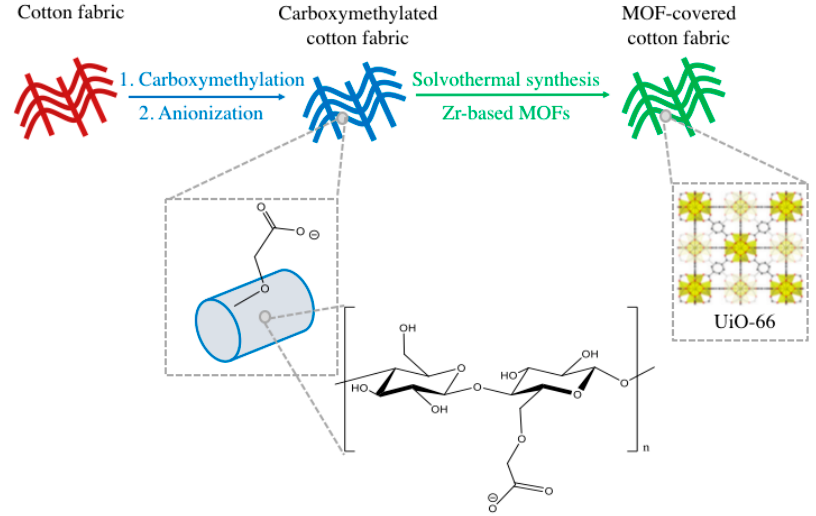
Figure 1. Schematic of the two-step synthesis pathway to grow UiO-66 on the surface of cotton fibers: The first step is the carboxymethylation of cellulose, and the second step is the low-temperature solvothermal synthesis of the metal-organic framework (MOF) on the surface of the carboxymethylated fibers.